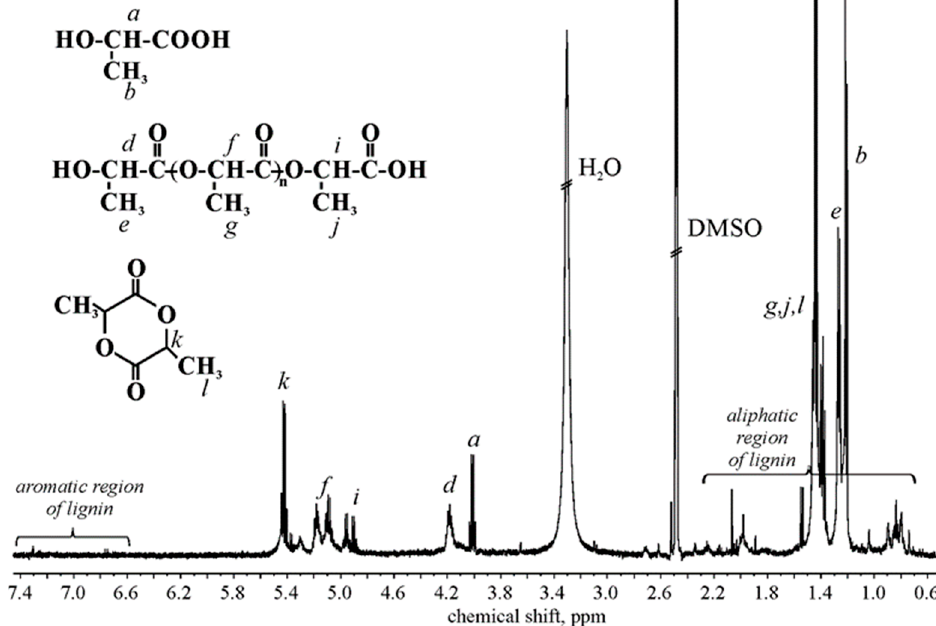
Figure 4. 1 HNMR spectrum of CP-g-OLA.